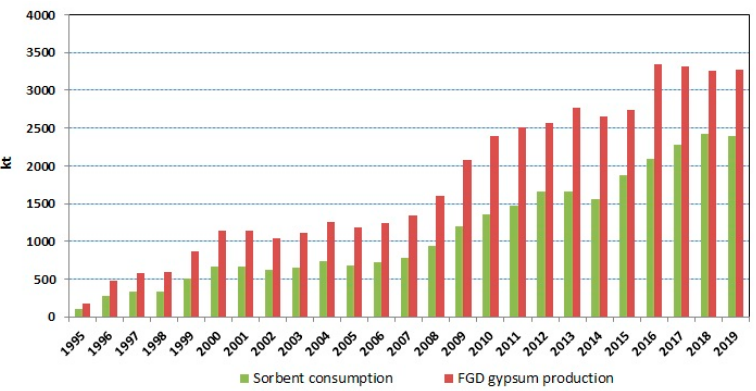
Figure 1. Comparison of the production volume of synthetic gypsum and consumption of limestone sorbents applied in flue gas desulphurisation in wet method (surveyed gypsum producers’ and sorbent consumers’ data).